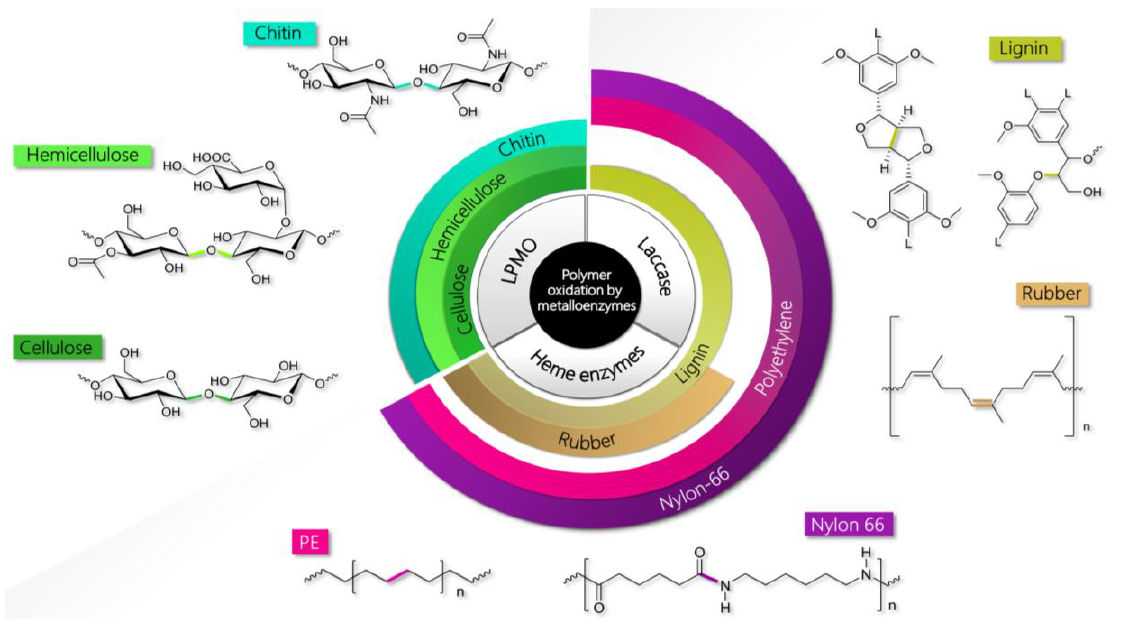
Figure 1. Oxidative metalloenzymes and their polymeric substrates discussed in this review.